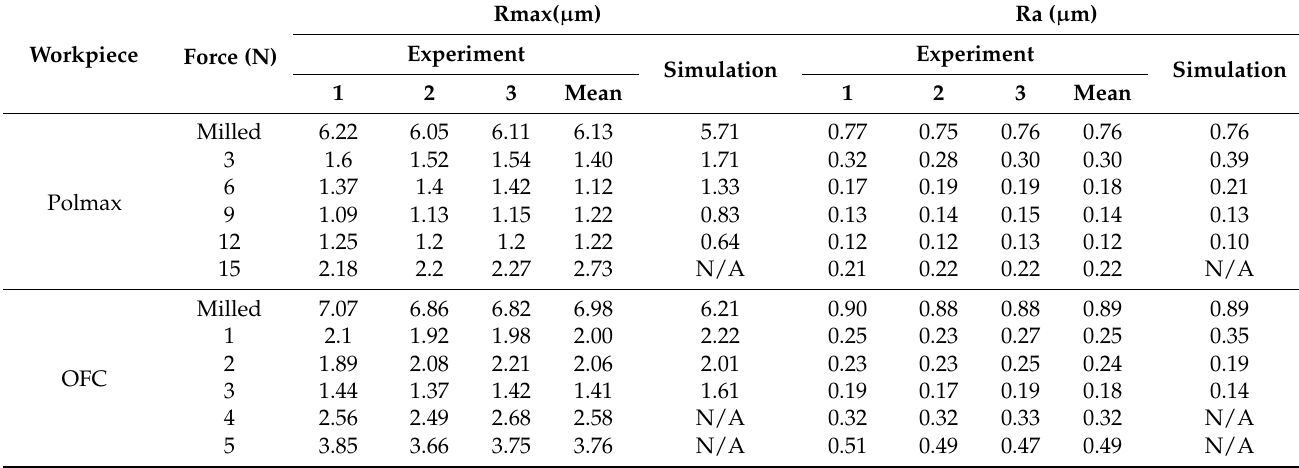
Figure 12. The experimental milled–burnished area of Polmax (optical microscope 30×). Table 1. Simulated and experimental surface roughness